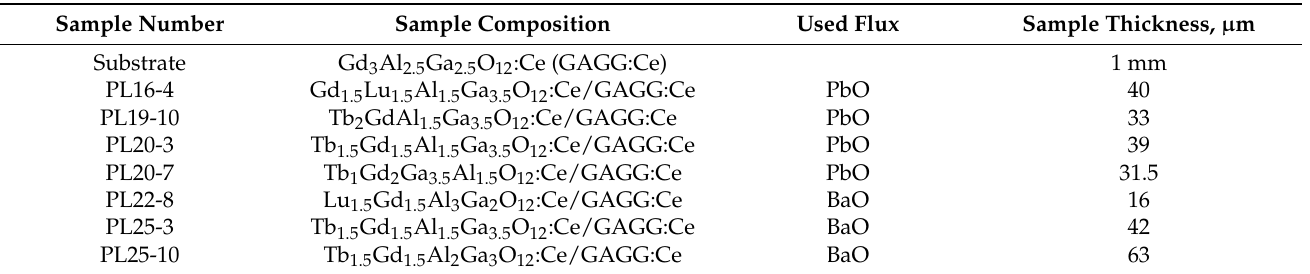
Table 2. List of the selected composite scintillators and their film thicknesses as used in detailed tests of scintillation performance.